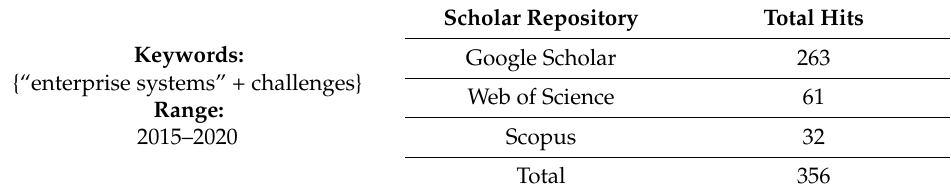
Table 2. Returned search hit counts with keyword {“enterprise systems” + challenges} between 2015 and 2020 for the eight basket journal outlets queried on Google Scholar, Web of Science, and Scopus.